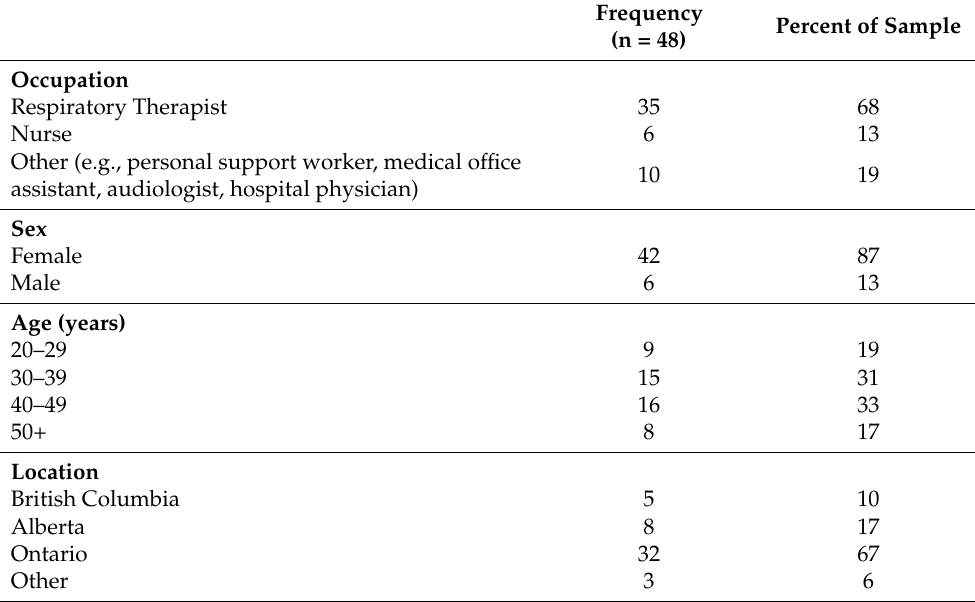
Table 1. Participant Demographics.